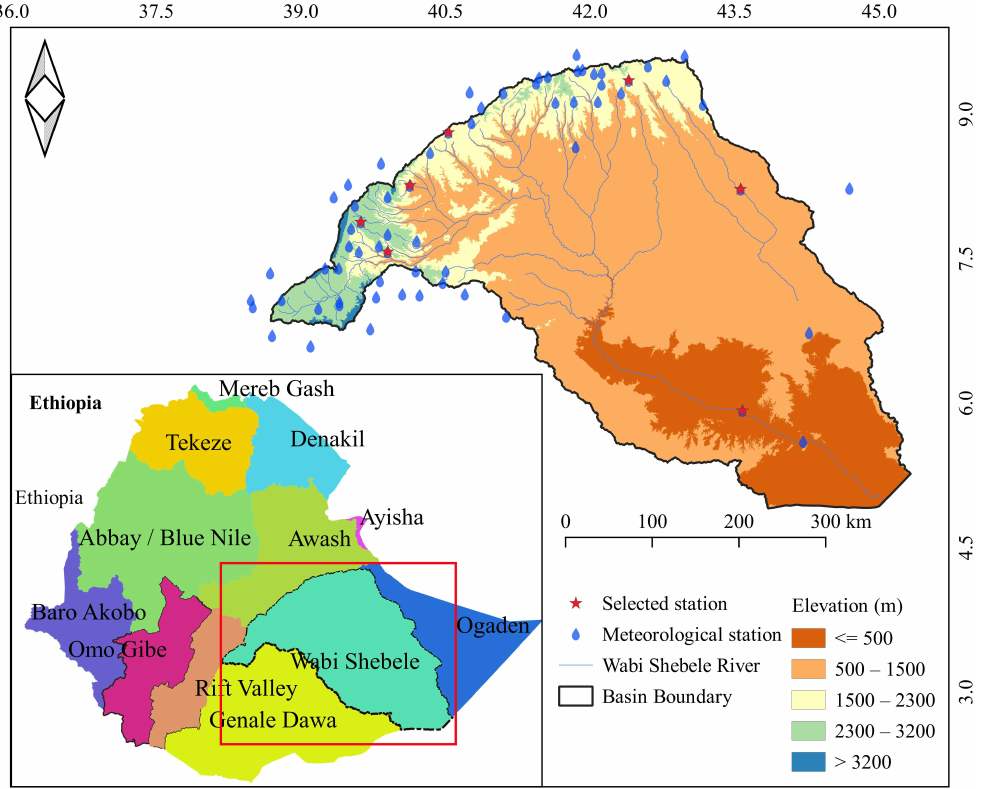
Figure 1. Location map of Wabi Shebele River Basin